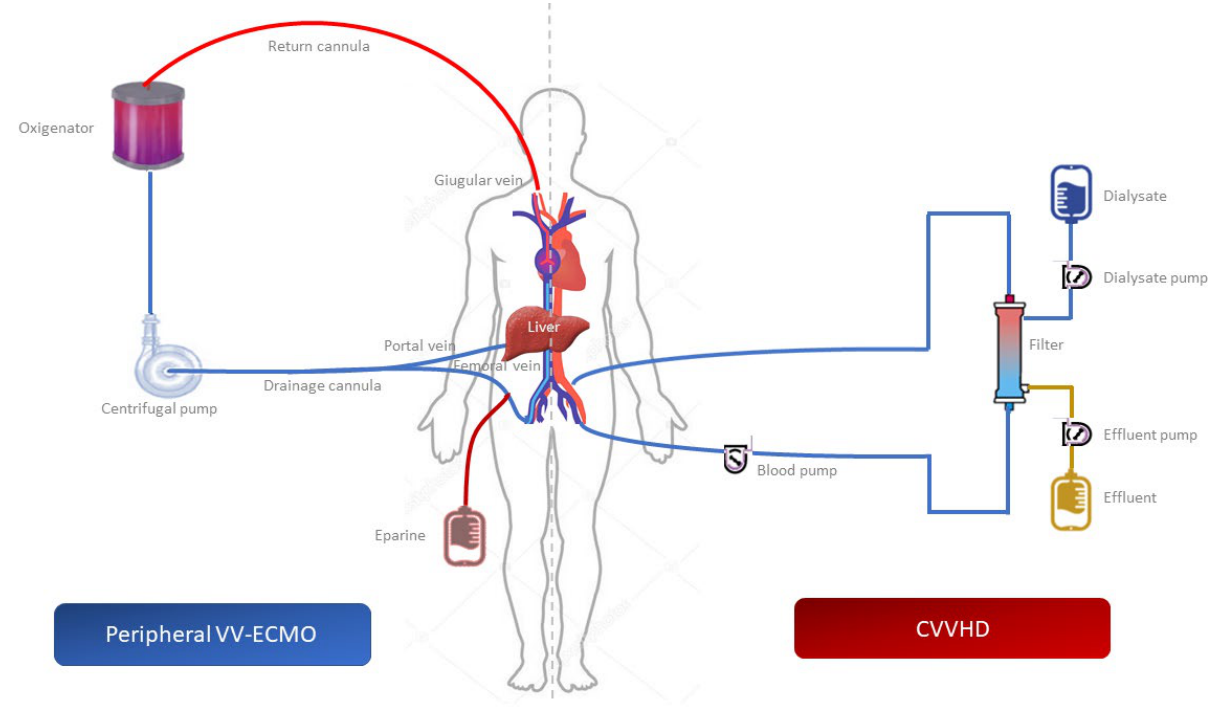
Figure 3. Graphic scheme of Veno-Venous Extracorporeal Membrane Oxygenation (VV ECMO) and Continuous Veno-Venous Hemodiafiltration (CVVHD).